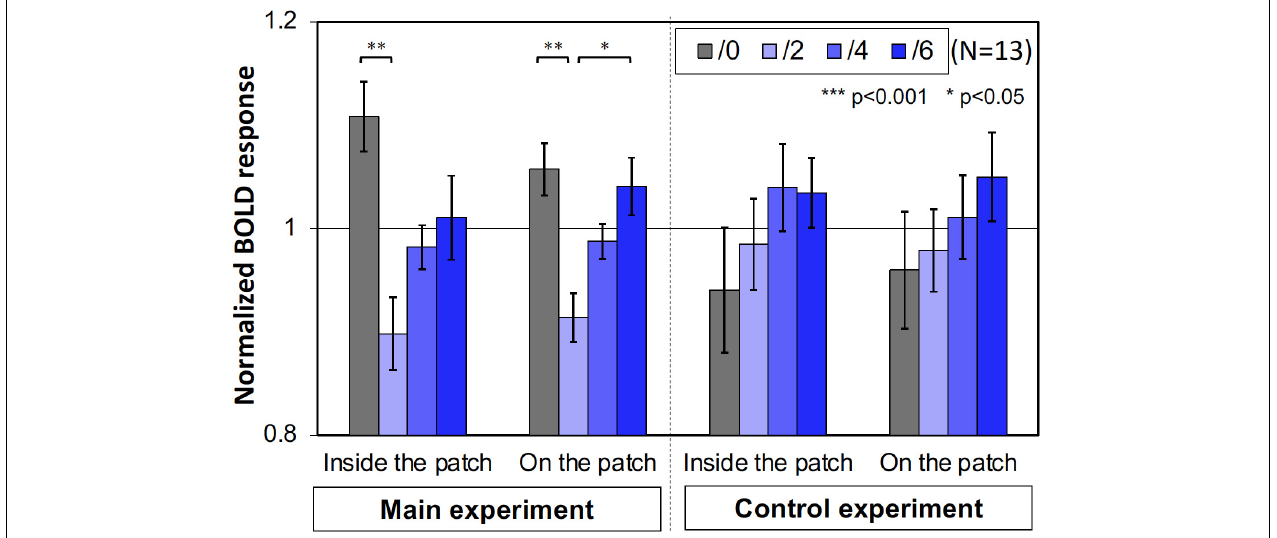
FIGURE 7 | The normalized brain activity of the areas corresponded to inside and on the patches. A one-way ANOVA for the data before normalization, showed a significant effect on both areas only in main experiment ( Table 1 ). Error bars denote SEM. Asterisks denote statistical significance by Tukey’s HSD test (** p < 0.01; * p <